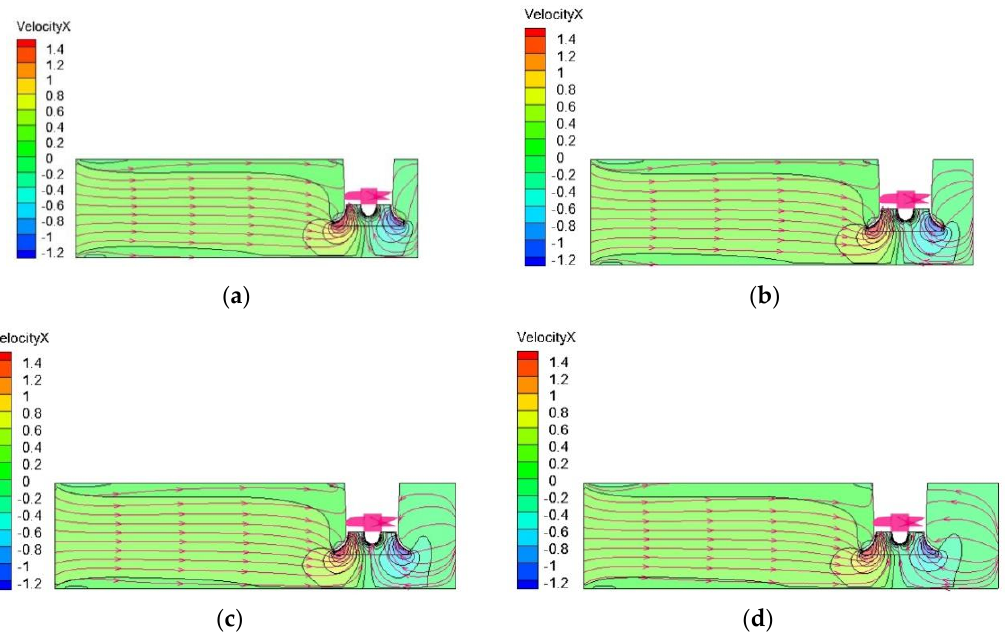
Figure 15. Velocity distribution of section 1-1 with different back wall distance. ( a ) Case 8, ( b ) Case 6, ( c ) Case 9 and ( d ) Case 10.